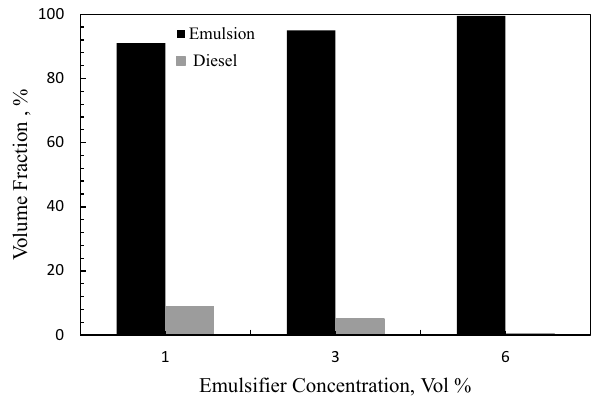
Fig. 9 Volume fraction of the emulsified gels at different WOR after 1 week at 25